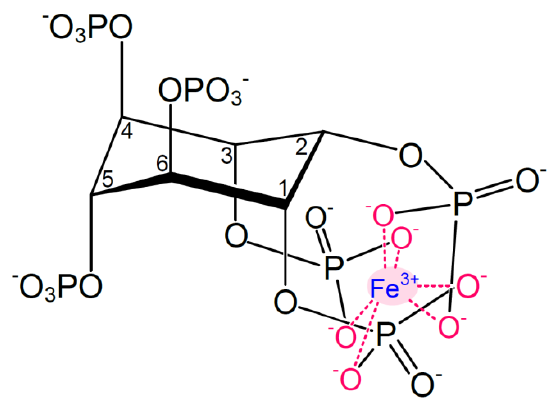
Figure 1. Structure of monoferric phytate, where Fe 3+ is chelated via its six coordination sites. Adapted from [3].